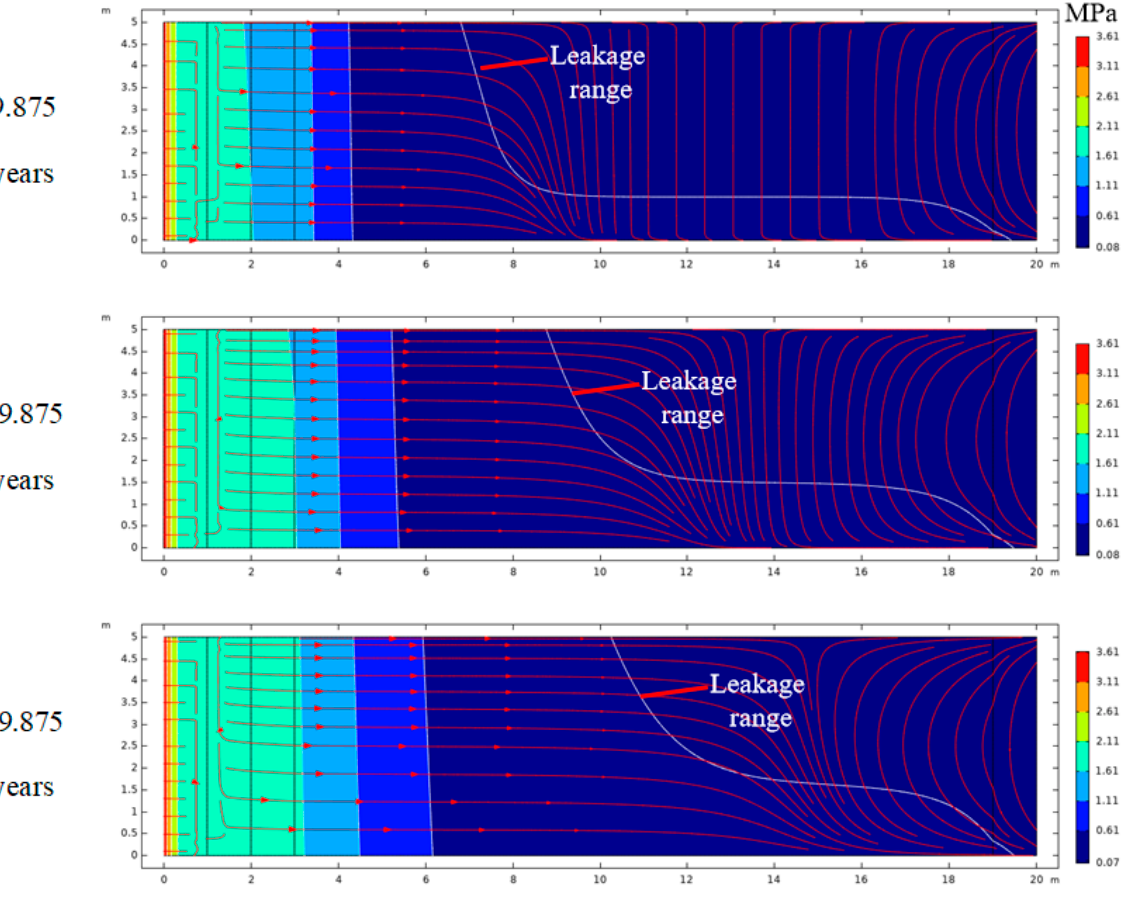
Figure 14. Changes of leakage range with